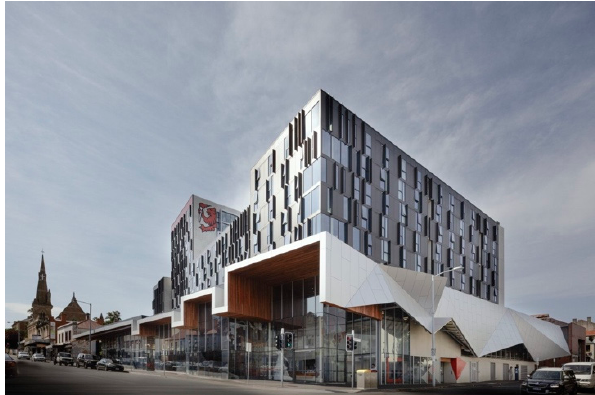
Figure 3. Street view of the apartment complex [Photographer: John Gollings Source, Terroir Architects].